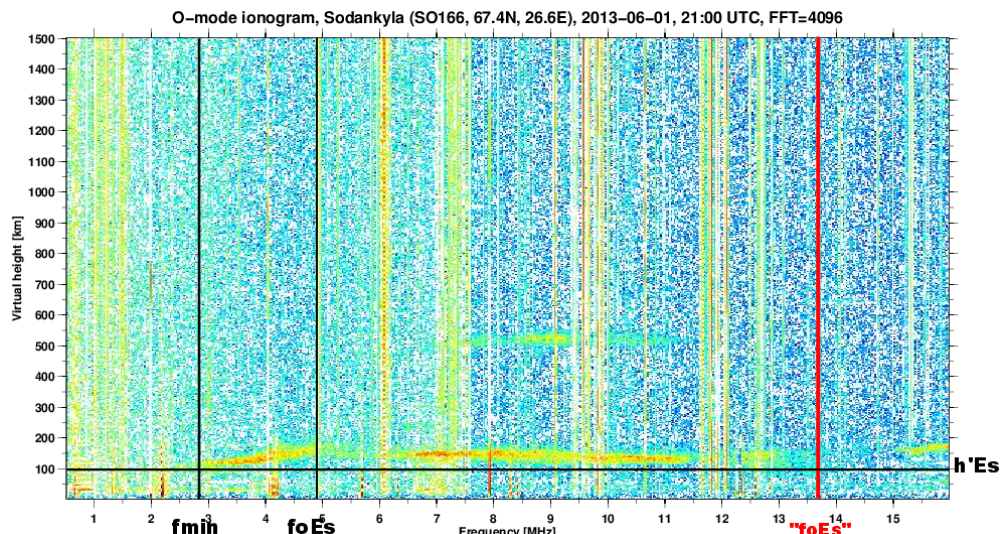
Figure 7. Differences between manual and Autoscala scaling arising from high latitude sporadic E phenomena. Black lines show manually scaled parameters, and red colour (lines and/or letter) indicates Autoscala results. Example 2: overestimated foE s (13.7MHz vs. manual